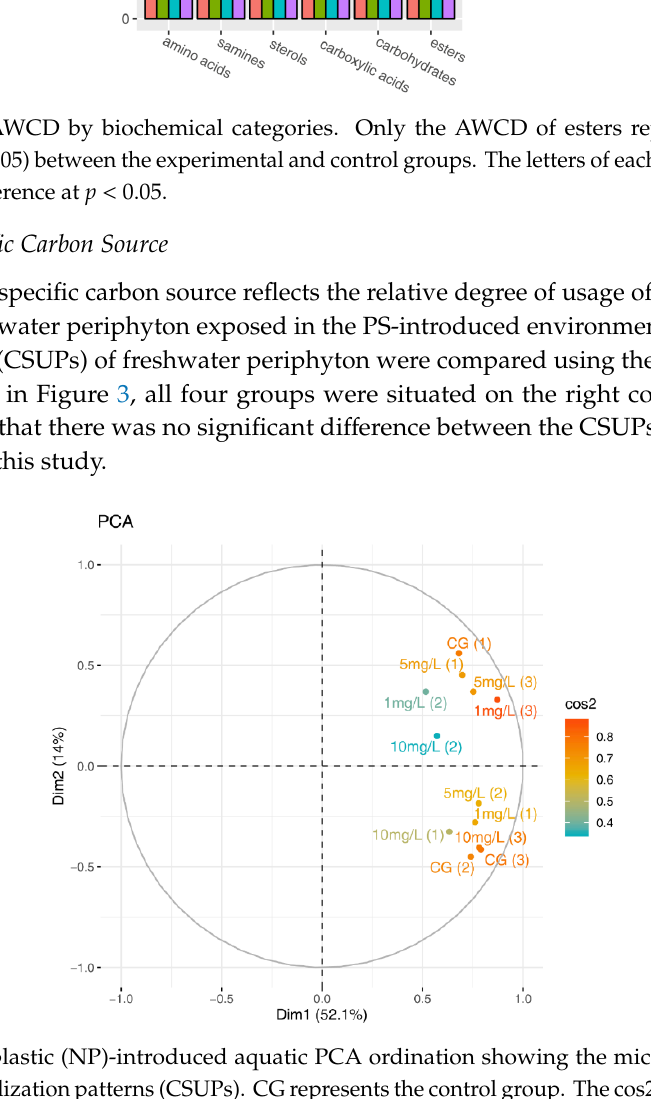
Figure 2. The AWCD by biochemical categories. Only the AWCD of esters reported significant differences ( p < 0.05) between the experimental and control groups. The letters of each column represent a significant difference at p < 0.05.